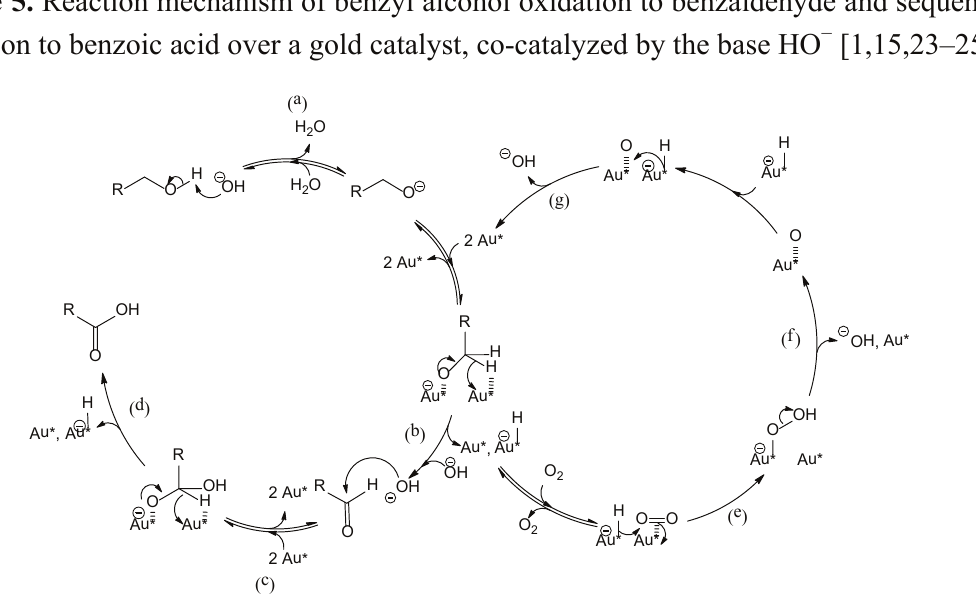
Figure 5. Reaction mechanism of benzyl alcohol oxidation to benzaldehyde and